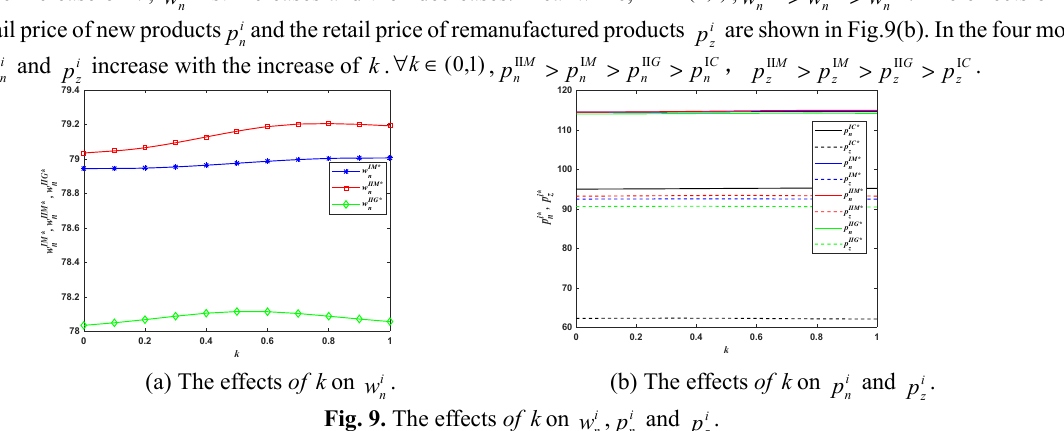
Fig. 9. The effects of k on i